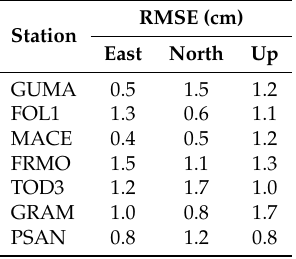
Table 3. Comparison between A-VADASE-LOO and PPP solutions: 26 October 2016